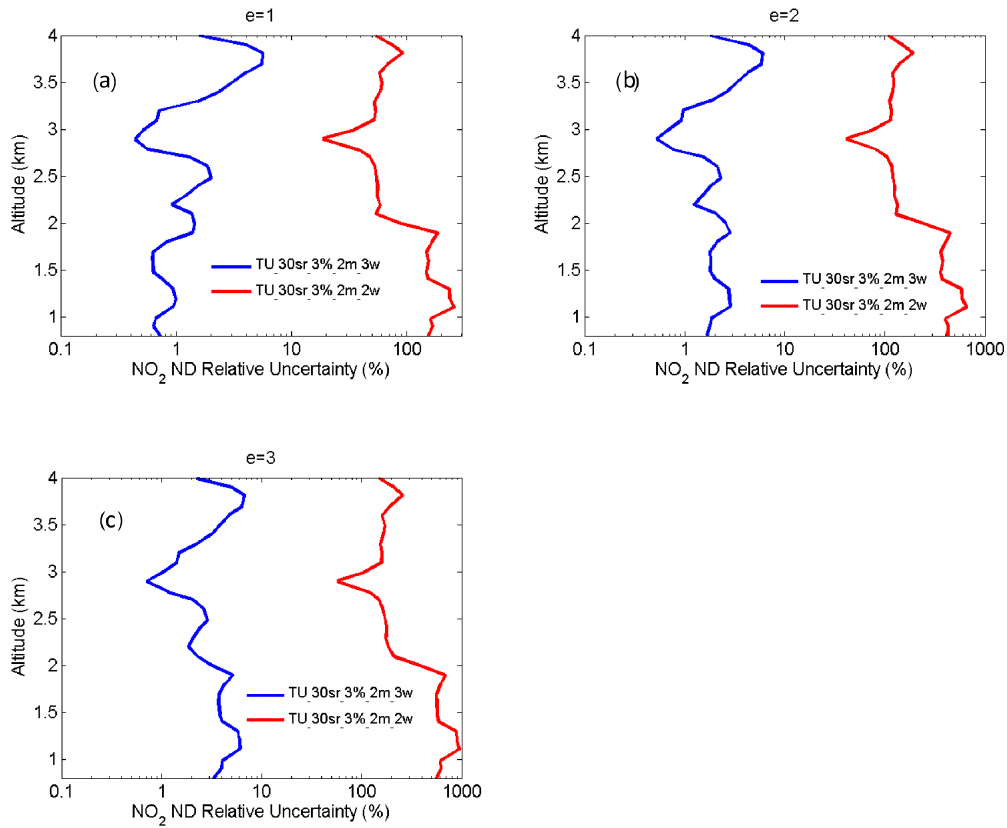
Figure 12. NO 2 number density total relative uncertainty with e = 1 (a) , e = 2 (b) and e = 3 (c) .